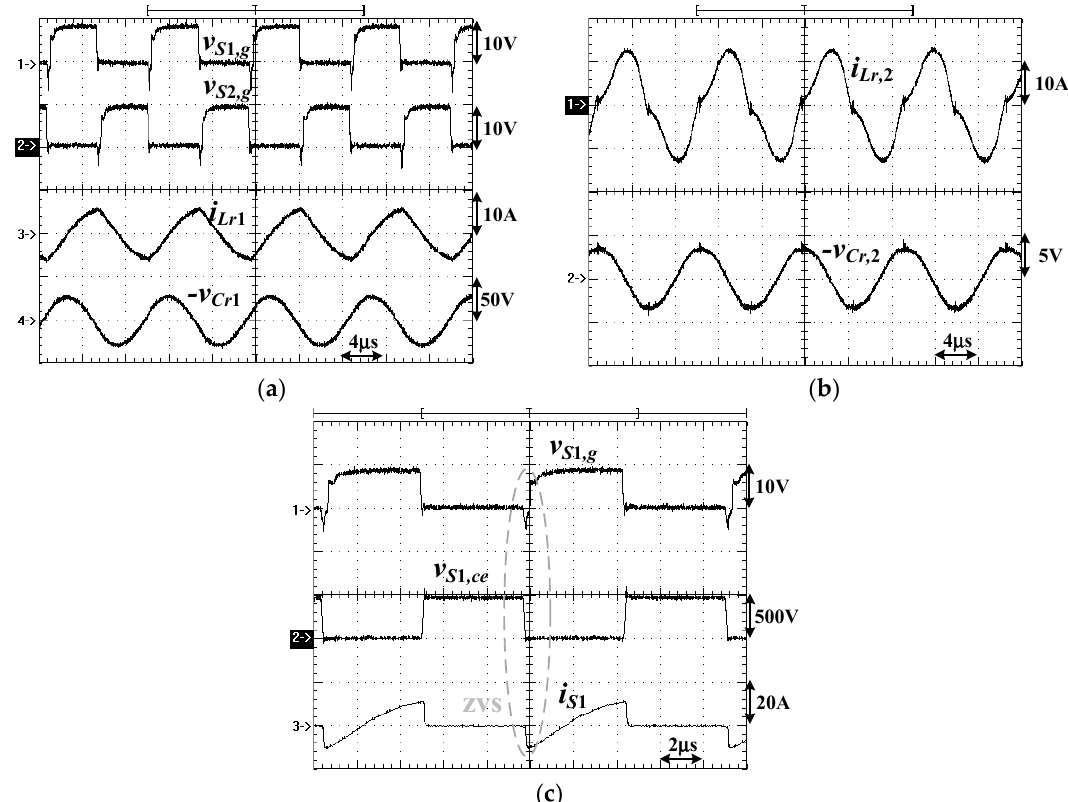
Figure 11. Measured results of the proposed converter under V in = 480 V, V o = 52 V, and I o = 7.8 A: ( a ) v S 1, g , v S 2, g , i Lr, 1 , and – v Cr, 1 ; ( b ) i Lr, 2 and – v Cr, 2 ; ( c ) v S 1, g , v S 1, ce , and i S 1 .